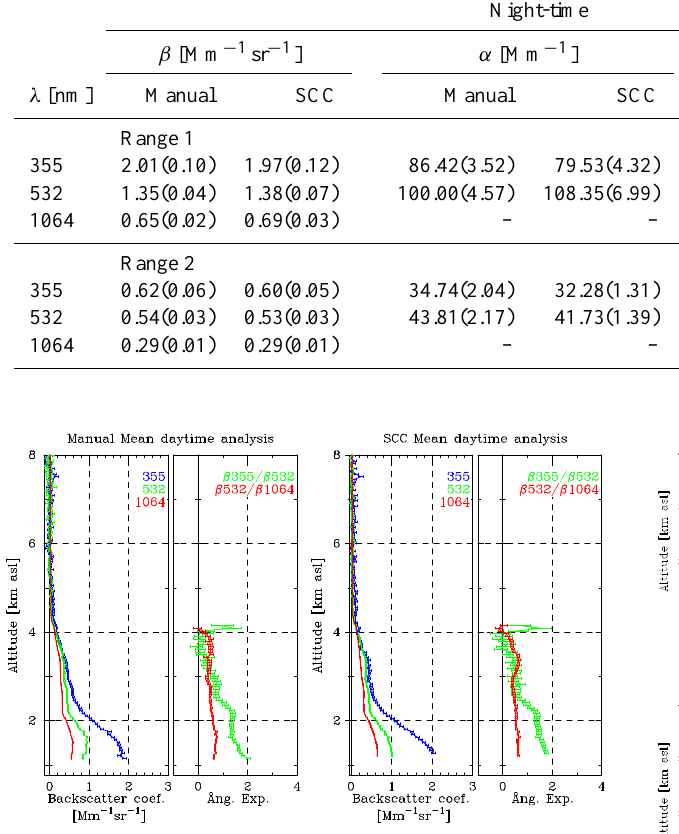
Figure 10. Mean daytime analysis comparison for the Potenza sta- tion (MUSA system). On the left the mean analysis obtained using the manual analysis is shown, while on the right the results obtained by the SCC are presented. Several measurement cases (see Table 2) have been analysed, and the corresponding backscatter profiles have been averaged (left two panels of each graph). The other panel of each graph shows the backscatter related Ångström exponents as calculated from the mean backscatter profiles.